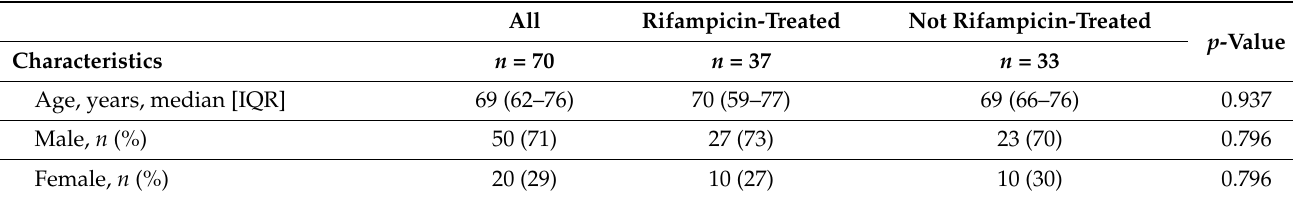
Table 1. Baseline clinical characteristics of 70 patients treated for chronic Cutibacterium acnes PJIs with rifampicin or